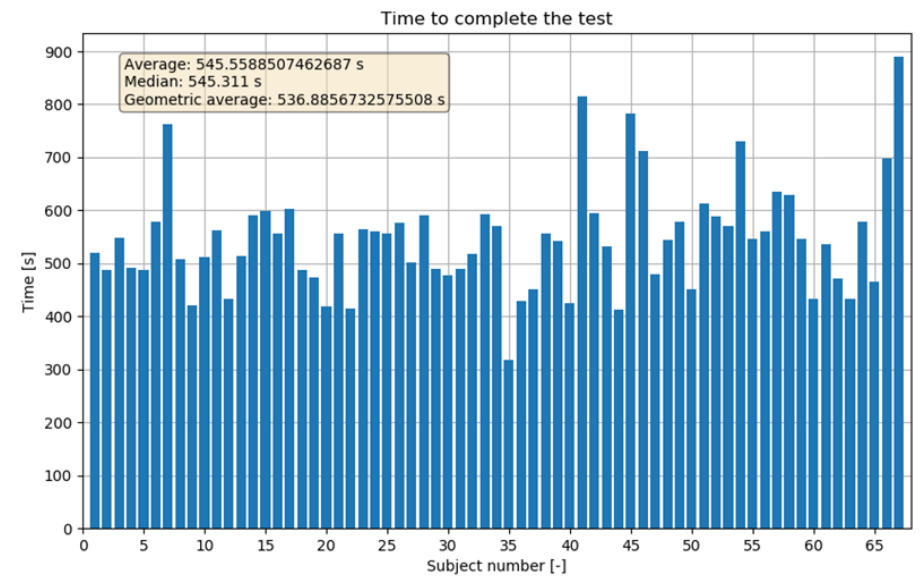
Figure 10. Time to complete the test.